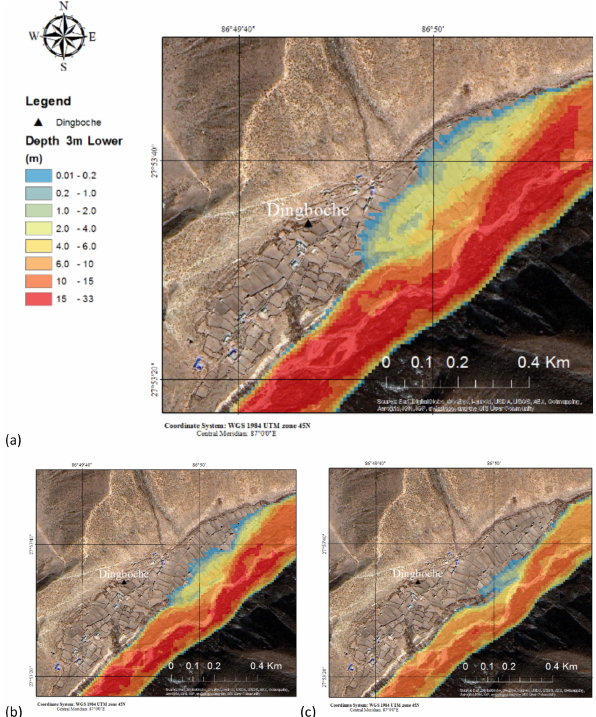
Figure 10. Inundation depth at Dingboche under current lake con- ditions: (a) 3m lake lowering, (b) 10m lake lowering and (c) 20m lake lowering.